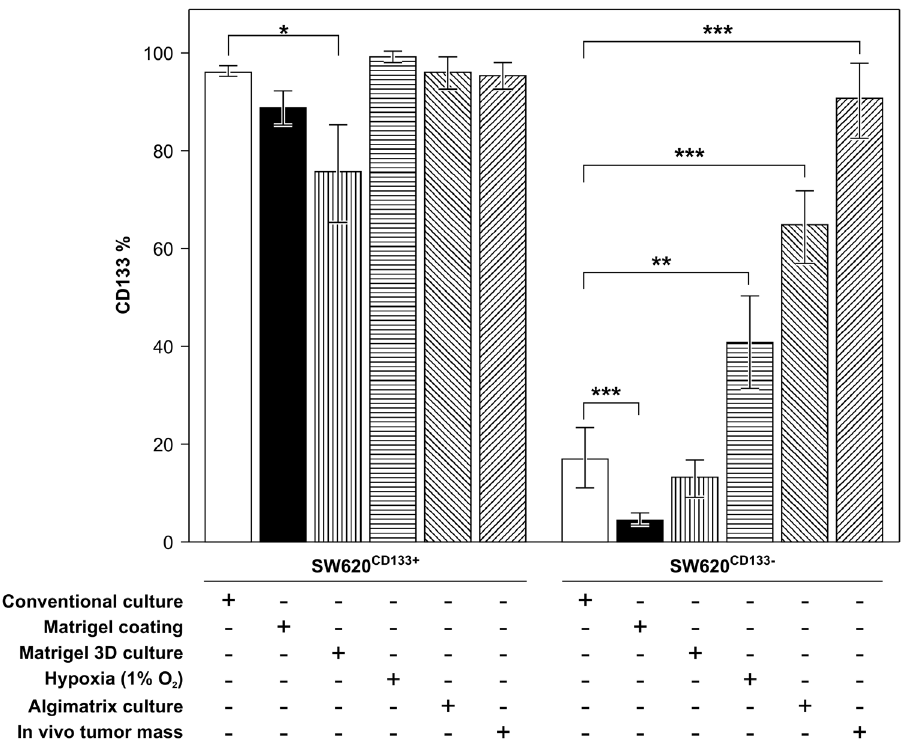
Figure 4. Modulation of CD133 expression in SW620 cells in reaction to exposure to stressors. Left panel shows SW620 CD133 + cells and right panel shows SW620 CD133 2 cells. Detail descriptions were shown in result.